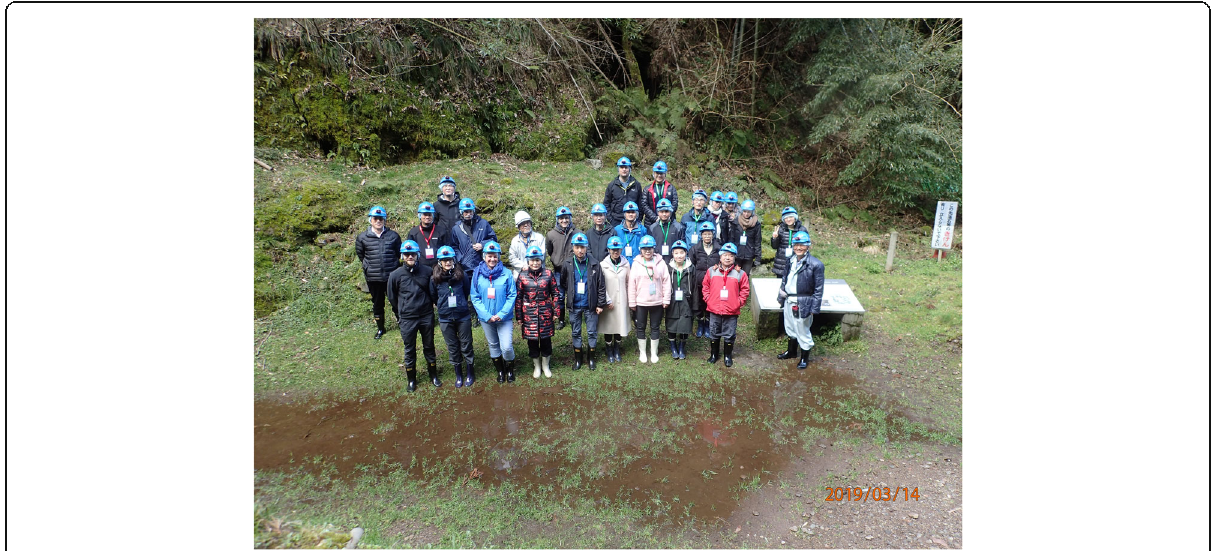
Fig. 1 Group photo in front of the mineshaft of Iwami Silver Mine